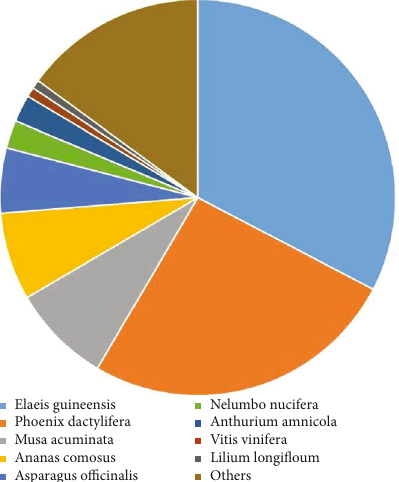
Figure 6: Homologous species distribution of tiger lily transcripts annotated in the NR